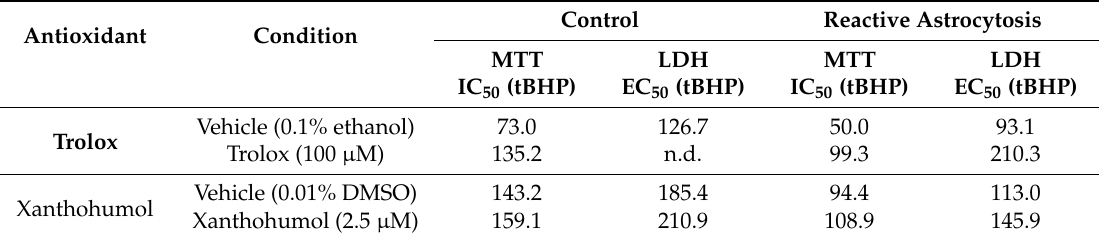
Figure 4. Glioprotective e ff ects of Mn-TM-2-PyP and resveratrol against reactive astrocytosis- and t BHP-induced oxidative stress. ( A ) Pretreatment of optic nerve head astrocytes with Mn-TM-2-PyP resulted in complete protection against both reactive astrocytosis- and t BHP-induced oxidative stress, as determined by MTT assay. ( B ) Similarly, lactate dehydrogenase (LDH) assay revealed potent glioprotection by Mn-TM-2-PyP. ( C ) Resveratrol exerted strong glioprotective e ff ects that resulted in a statistically significant shift in the IC 50 value for t BHP. ( D ) Similar shifts were observed in the t BHP dose-response curve in the LDH assay. Data are shown as mean ± s.e.m. from three (Mn-TM-2-PyP) or four (resveratrol) separate experiments, with eight technical replicates per experiment. Table 2. Trolox and xanthohumol are glioprotective against reactive astrocytosis- and chemically induced oxidative stress. (n.d. = not determined).